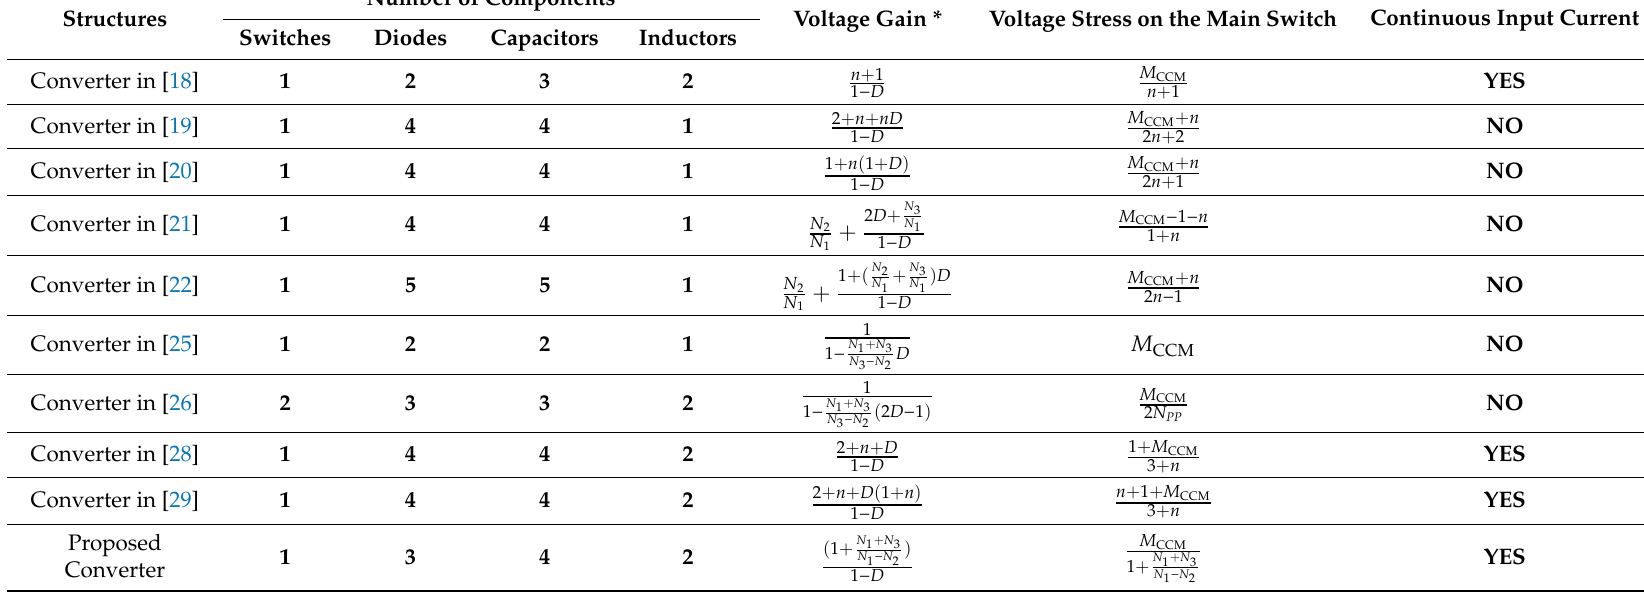
Table 1. The key features of the various